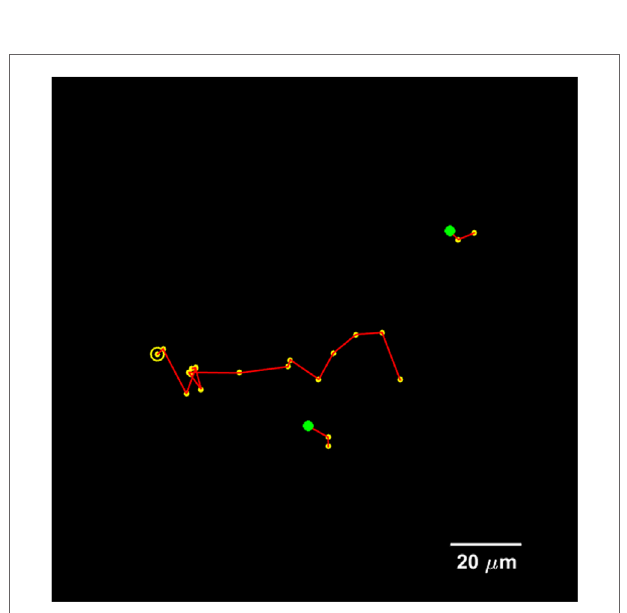
FIGURe 5 | tracking diagram of the U251 cell(s) that are present in Figure 4 for a total duration of 20 frames, which corresponds to 3.5 h . The yellow circle indicates the initial parent position, each yellow marker indicates subsequent positions, and the green markers indicate the initial positions of the daughter cells.